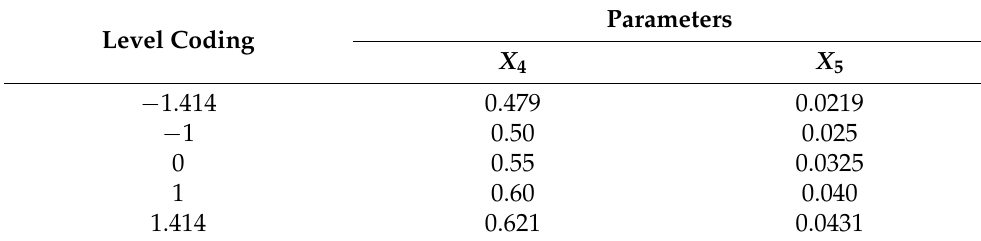
Table 8. Level coding table for simulation